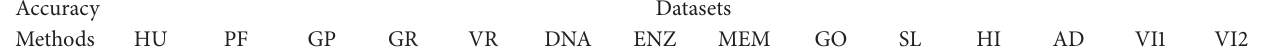
Table 10: Comparison with the state-of-the-art using accuracy as performance indicator.